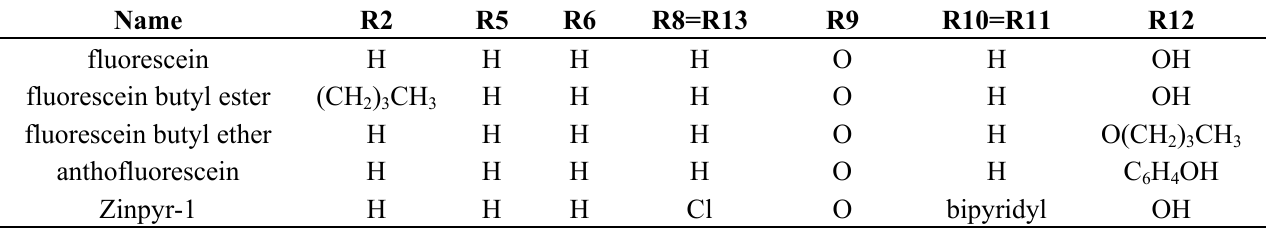
Table 5. R-groups within a series of fluorescein derivatives not approved for use in humans.